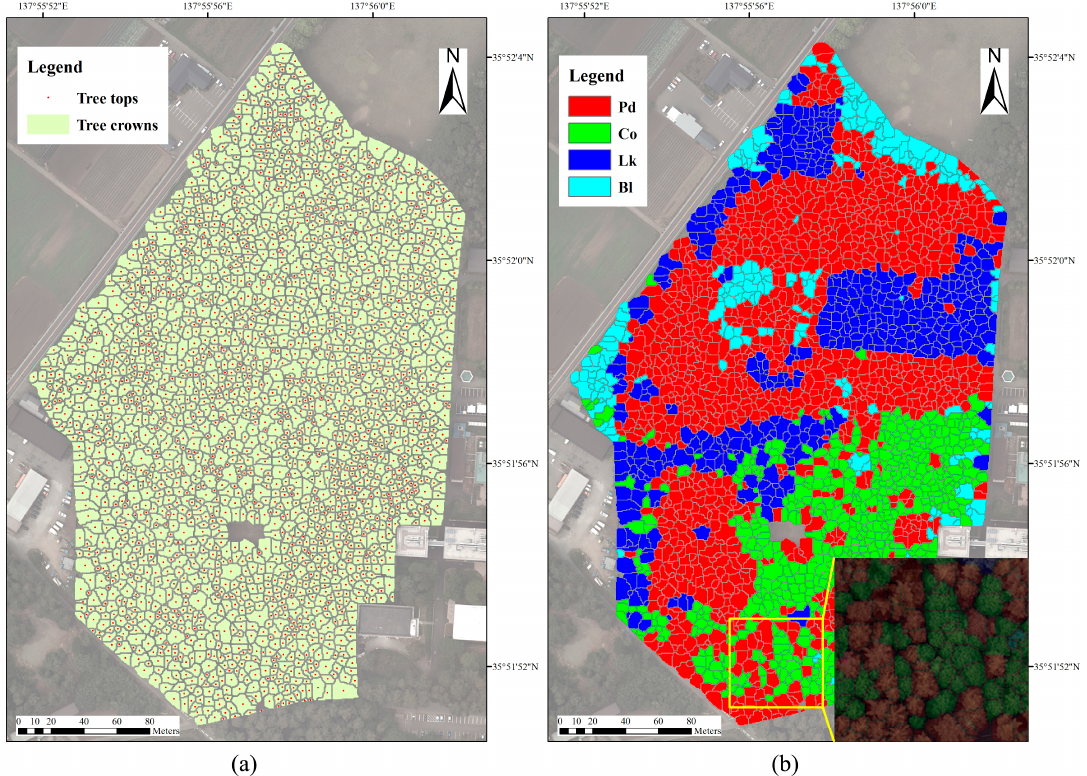
Figure 8. Delineated tree crowns and tree tops using the CHM data ( a ); and manually identified tree species ( b ). Pd, Pinus densiflora ; Co, Chamaecyparis obtusa ; Lk, Larix kaempferi ; Bl, broadleaved trees.